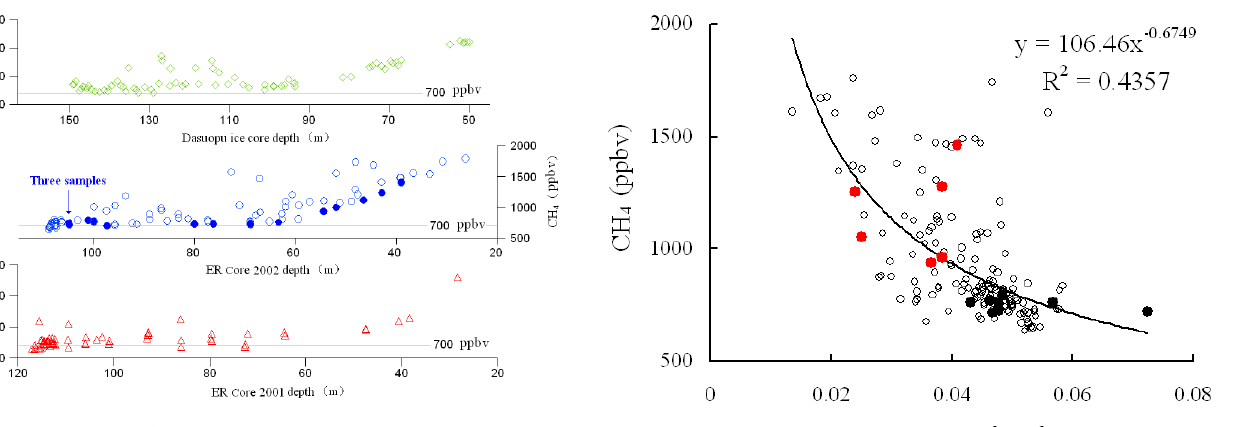
Fig. 1. CH 4 profiles from three Himalayan ice cores. The average 700ppbv preindustrial CH 4 level depicted by polar ice cores is in- dicated with a horizontal light blue line. The solid circles in the ER Core2002 panel stand for the filtered 15 samples that are used for the discussion.